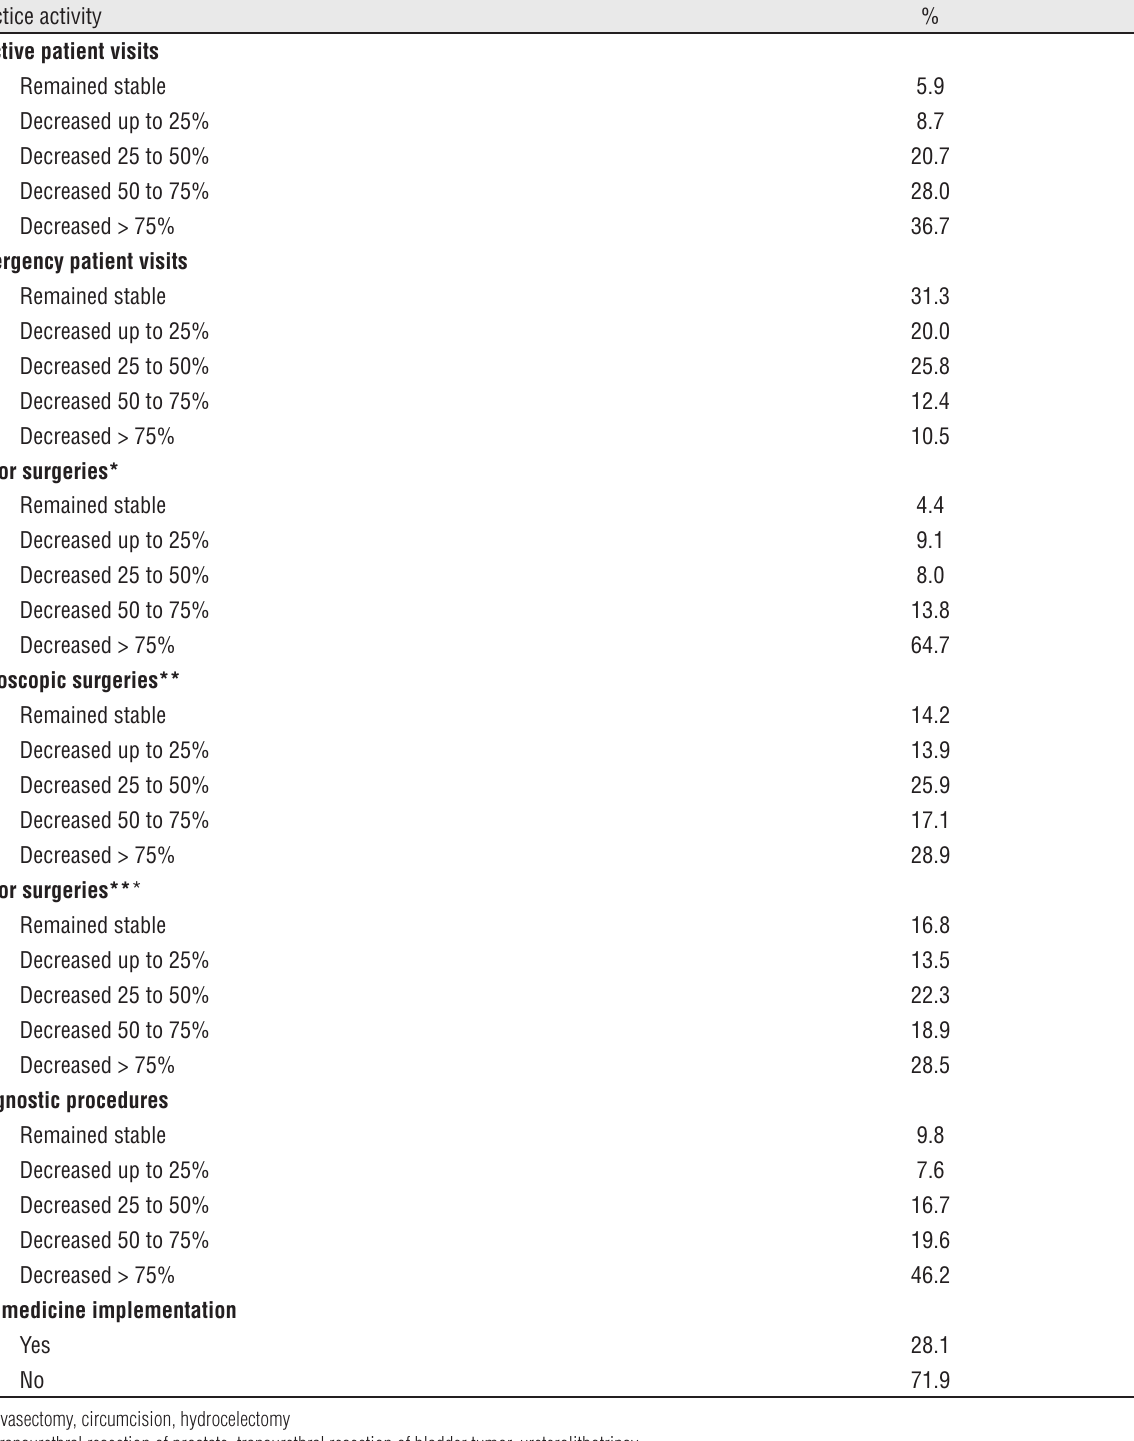
Table 1 - Impact of COVID-19 on Brazilian urology residents’ clinical